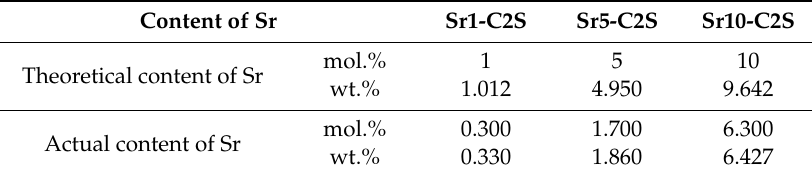
Figure 3. SEM images of Sr10-C2S particles and corresponding EDS element mapping images. Table 4. Content of Sr element in Sr-C2S tested by XRF.